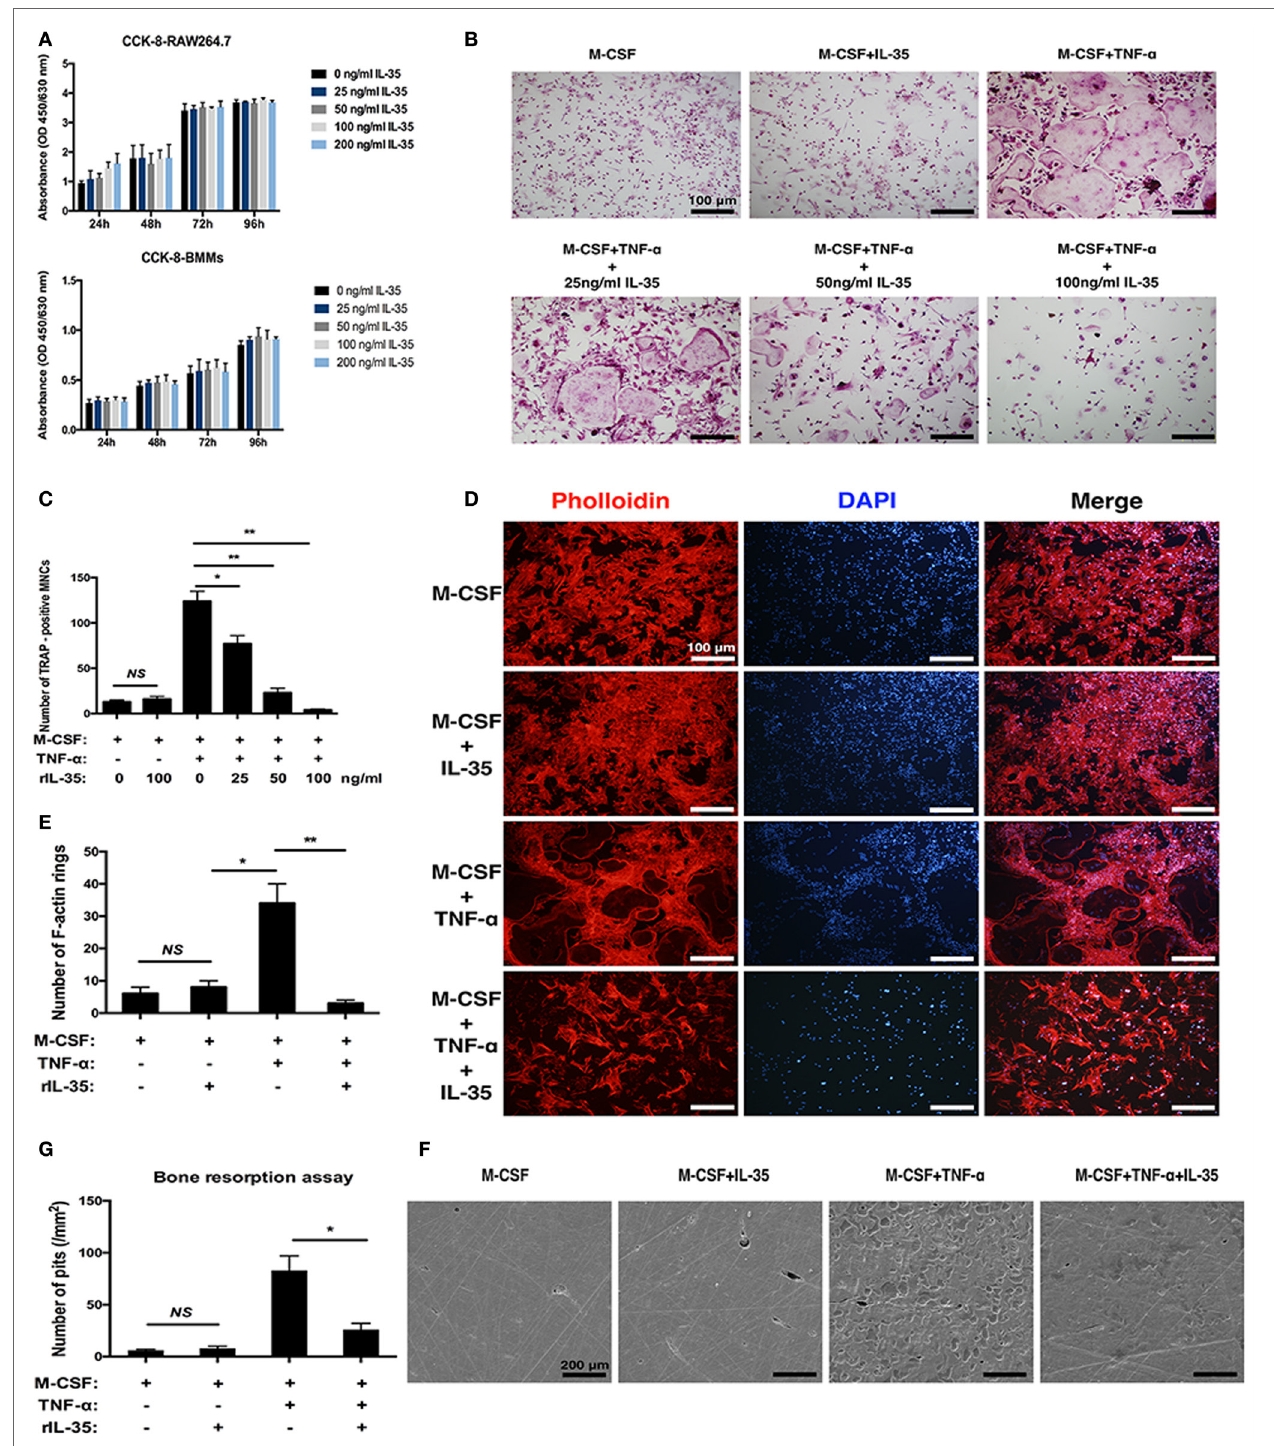
FigUre 1 | The effect of interleukin 35 on TNF- α -induced osteoclastogenesis in vitro . (a) cell viabilities were measured at the treatment of vary concentrations using Cell Count Kit-8 (CCK-8). (B) TNF- α N induced signaling complex and apoptotic signaling via TNFR1. (c) Cell numbers of tartrate-resistant acid phosphatase staining positive cells were counted and analyzed. (D) F-actin and nucleus in osteoclast were visualized by Phalloidin and DAPI, respectively. (e) Numbers of F-actin were counted and analyzed. (F) Scanning electronic microscopic images of bovine bone slices seeded with osteoclasts induced by different cytokines. (g) Numbers of bone resorption pits were counted and analyzed. * p < 0.05, ** p <